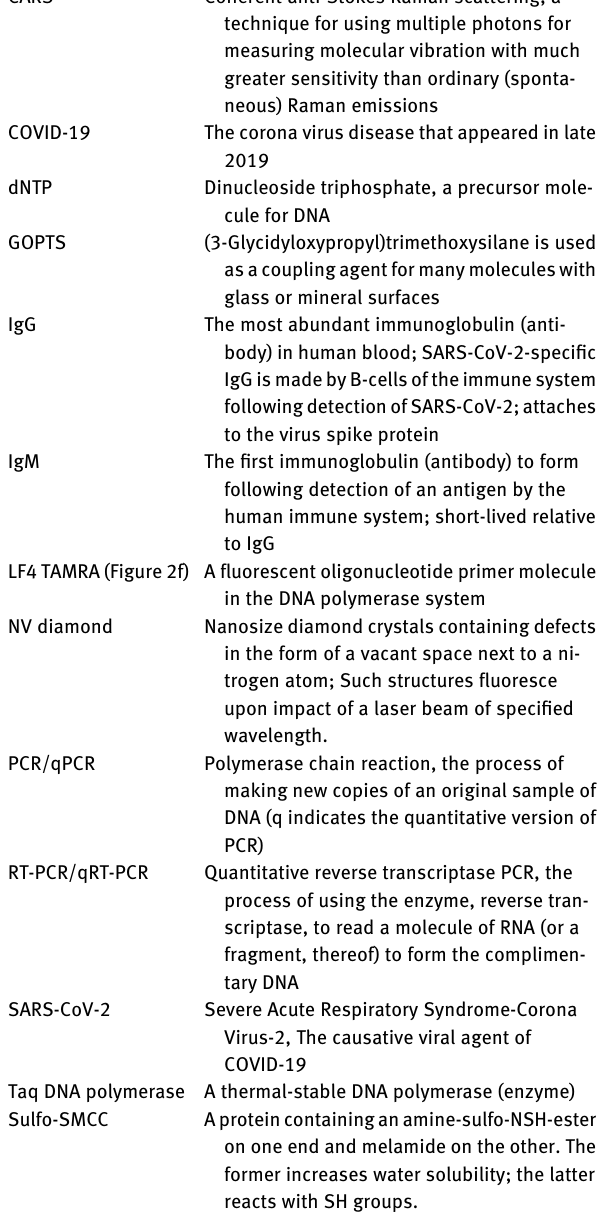
Table A  : Summary of